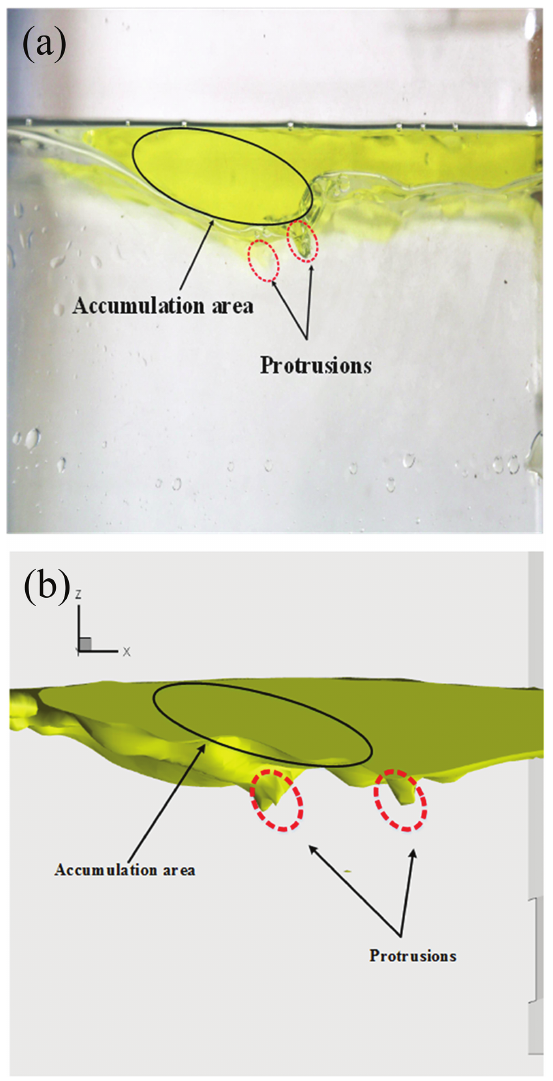
Figure 7: The comparison between (a) experimental observation and (b) simulation results for the accumulation and protrusions of the oil